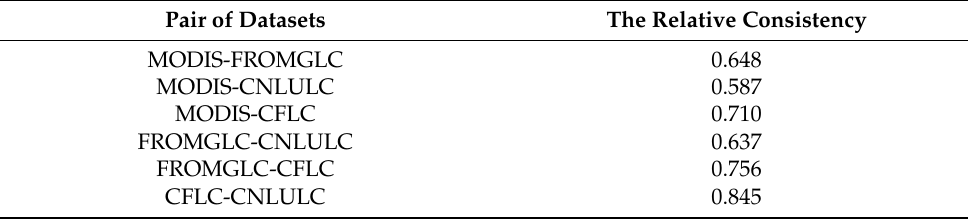
Table 5. The relative consistency between different land cover